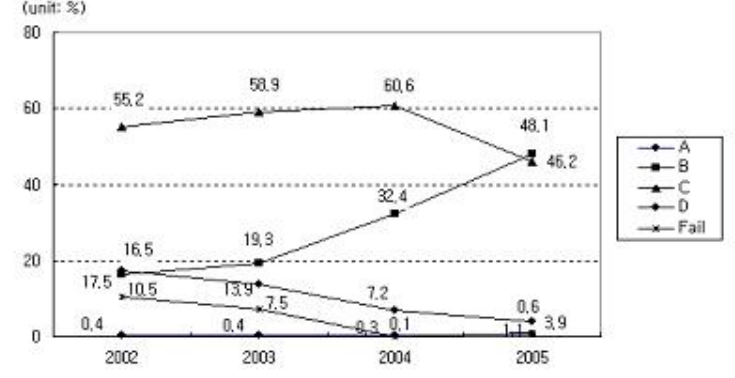
Figure 2. e-Learning Program Assessment Results (2002-2005)